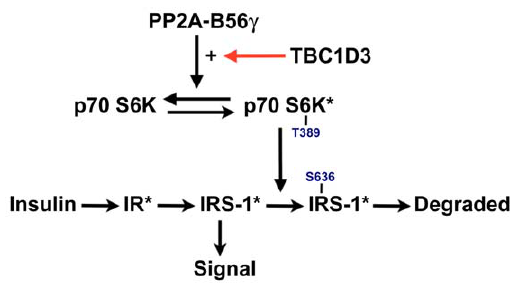
Figure 7. Model for the regulation of IRS-1 degradation by TBC1D3 expression. We propose that TBC1D3 suppresses the degradation of IRS-1 by regulating the phosphorylation of S6K at T389. In this model, mTOR phosphorylates S6K in response to insulin signaling. TBC1D3 interacts, directly or indirecly, with PP2A B56 c to enhance the dephosphorylation of S6K:T389 thereby reducing the S6K- dependent phosphorylation of IRS-1 at key sites which are required for IRS-1 ubiquitination and